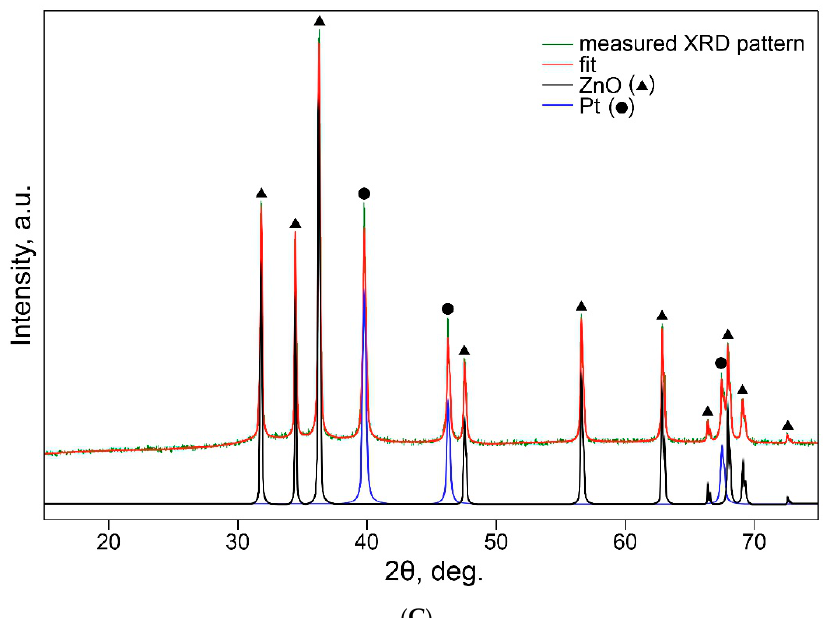
Figure 3. X-ray diffraction (XRD) spectra of the platinum-based powder ( A ), sintered material ( B ) and mixture (1:1 by weight) of the platinum-based powder with ZnO powder, used as a crystalline internal standard ( C ). The spectra were acquired by using Cu K α radiation. The lines corresponding to Al 2 O 3 observed in the spectrum of the sintered material are due to the contribution of alumina substrate, used for the deposition of the formulated ink.